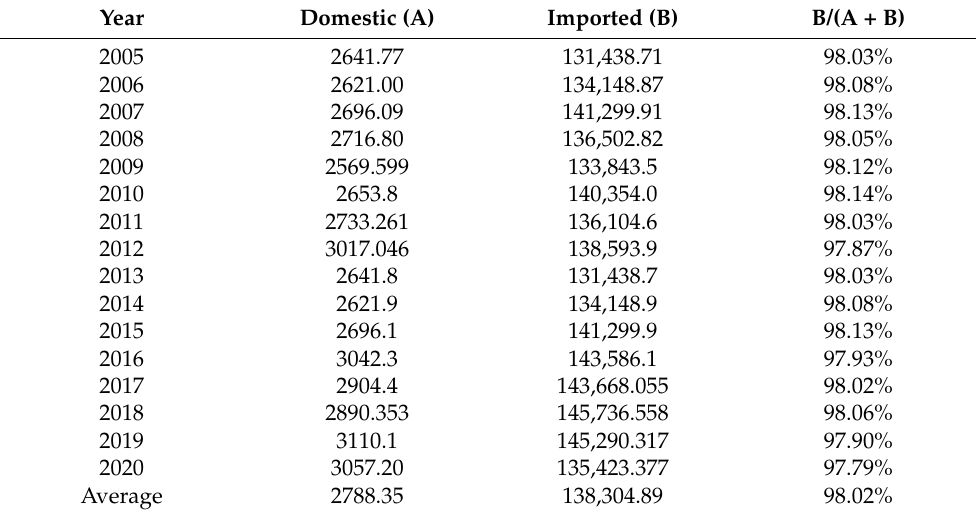
Table 1. Domestic and imported energy in Taiwan.